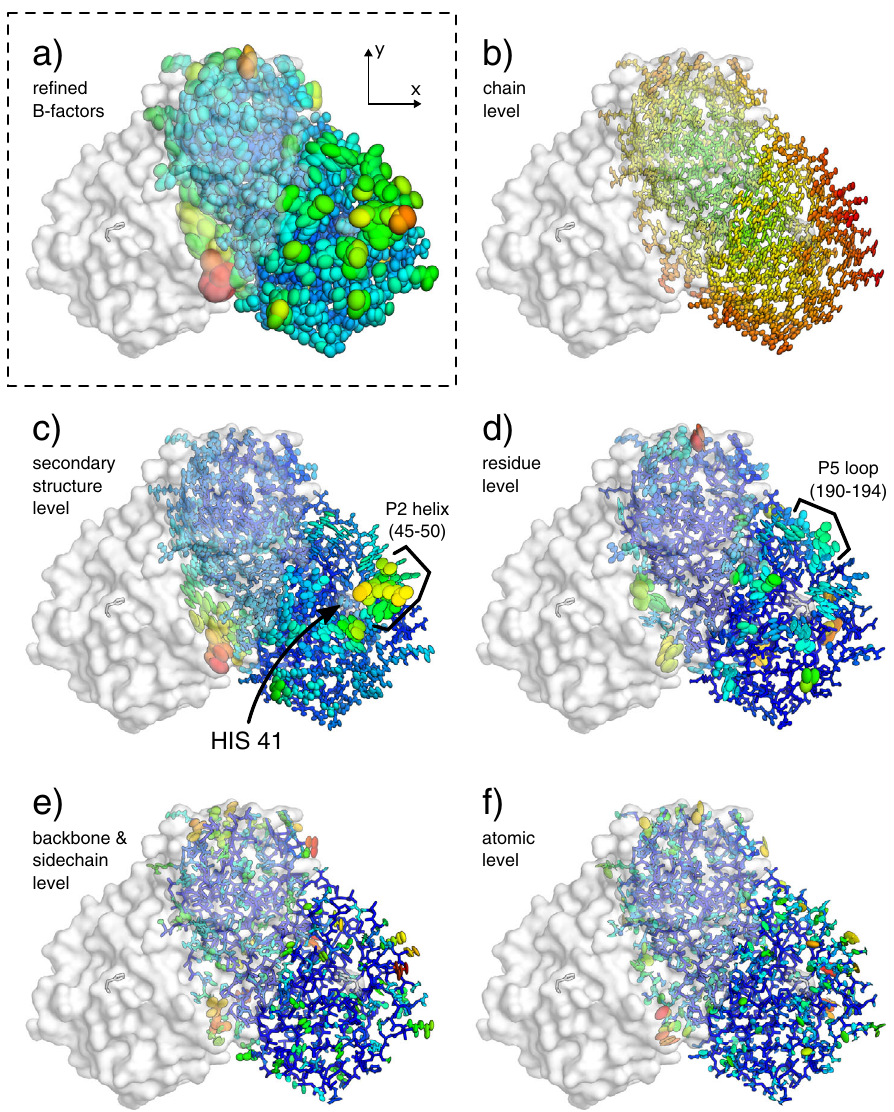
Fig. 4 ECHT decomposition of a structure of the SARS-CoV-2 main protease (7k3t). The protein is shown as lines and ellipsoids, coloured by B-factor for each structure independently from blue (zero) to green to red (maximum); the symmetry-related copy creating the obligate homodimer is shown as semi- transparent surface. The binding site histidine (HIS 41) is also shown as a semi-transparent surface, and as sticks in both monomers. B-factor ellipsoids are contoured at p = 0.95. a Re-re fi ned structure from PDB_REDO 21 (1.2 Å resolution; R work / R free 0.14/0.16; re fi ned with a-ADPs; B-factors 7.7 – 77.6 Å 2 ). b – f Disorder components of each ECHT level (maximum B-factor in brackets): b chain (7.4 Å 2 ), c secondary-structure (30.2 Å 2 ), d residue (35.9 Å 2 ), e backbone & sidechain (14.4 Å 2 ) & ( f ) atomic (19.0 Å 2 ). c , d Flexible segments and residues line the sides of the catalytic site (see also